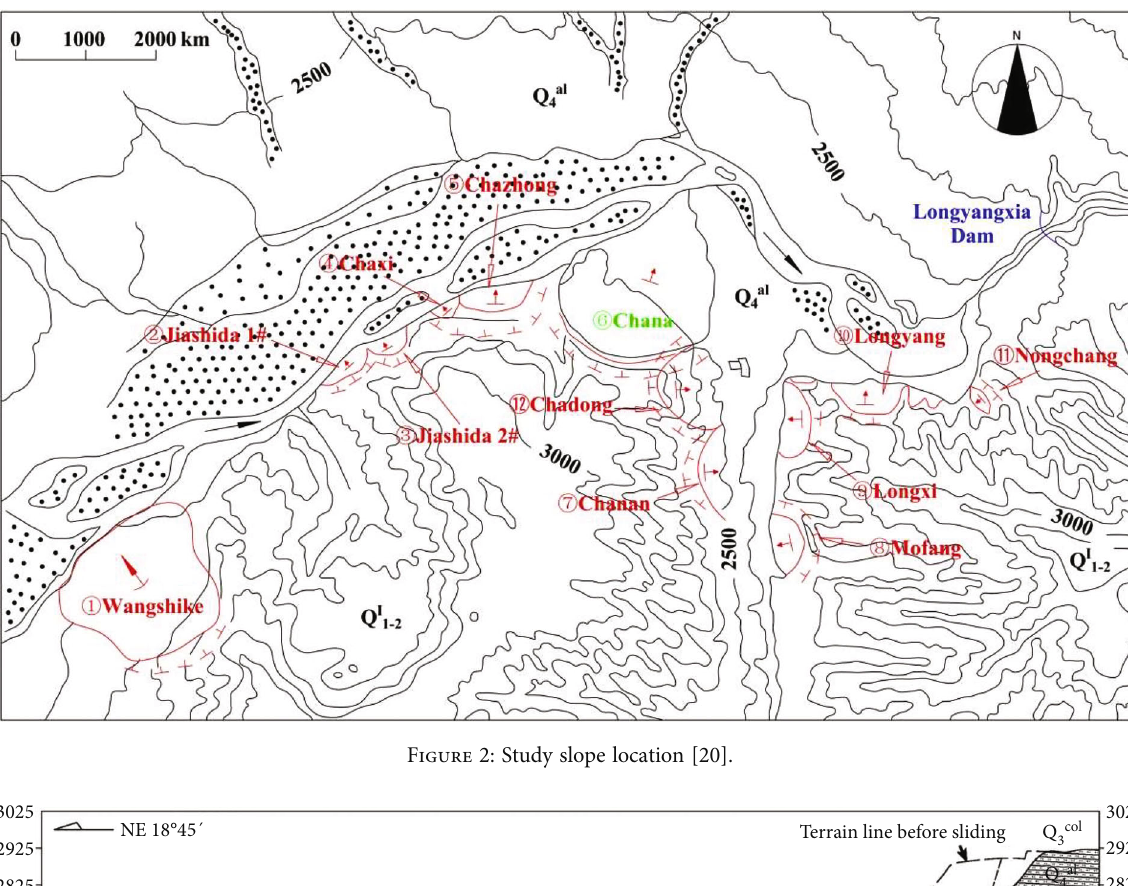
Figure 2: Study slope location [20].